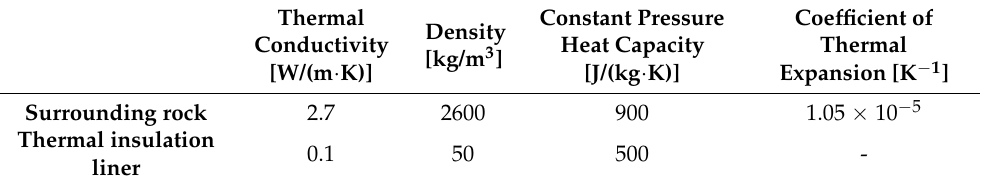
Table 3. Thermophysical parameters of surrounding granite and the thermal insulation liner.